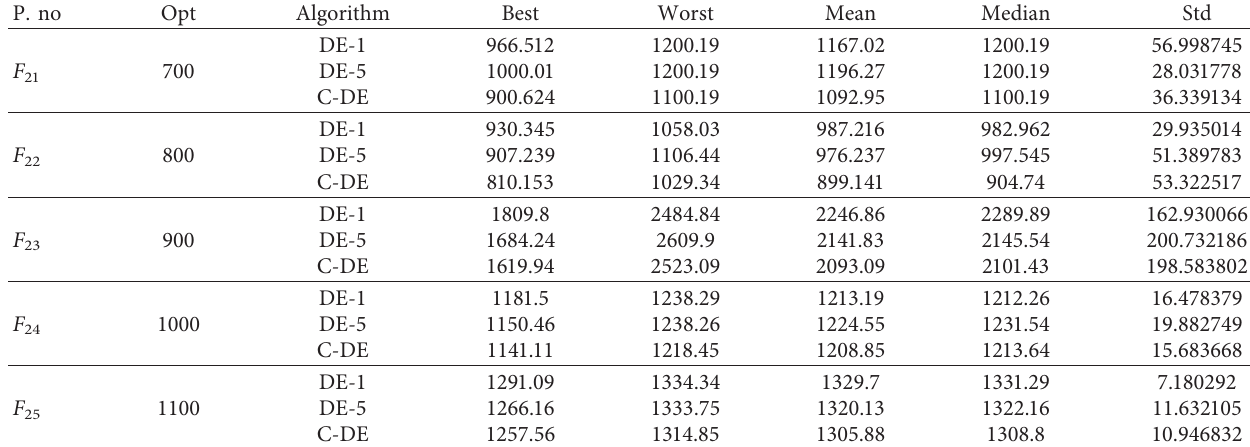
Table 3: The experimental results obtained by DE-1 and DE-5 versus proposed C-DE by solving CEC’13 benchmark functions F n � 10 dimensions. P.